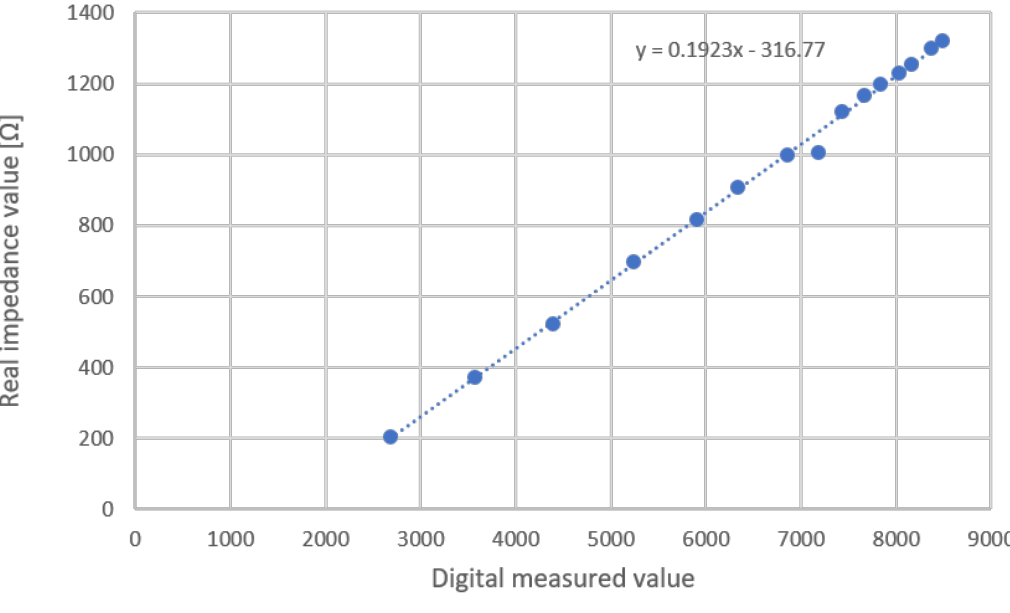
Figure 6. Calibration of TEB device channels. In the equation, x is digital measured values and y is impedance in Ω